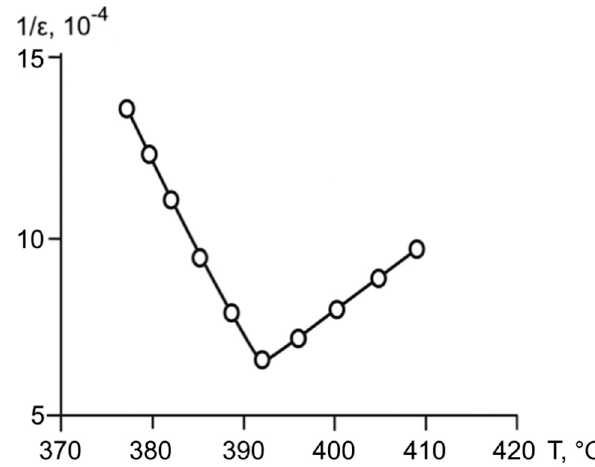
Figure 3. Dependence of the reverse dielectric permittivity on the temperature for BaZrO 3 /BaTiO 3 superlattice.